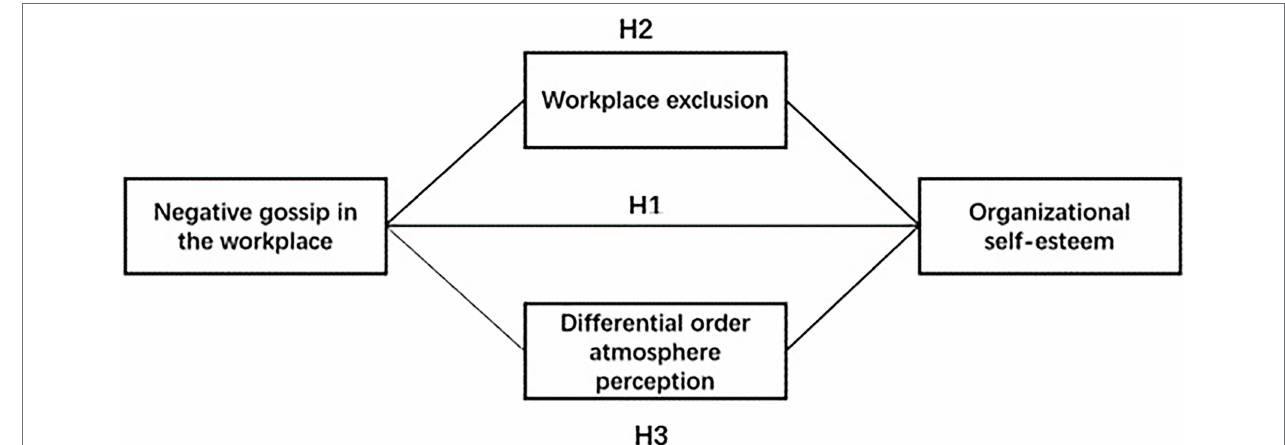
FIGURE 1 | Theoretic analysis